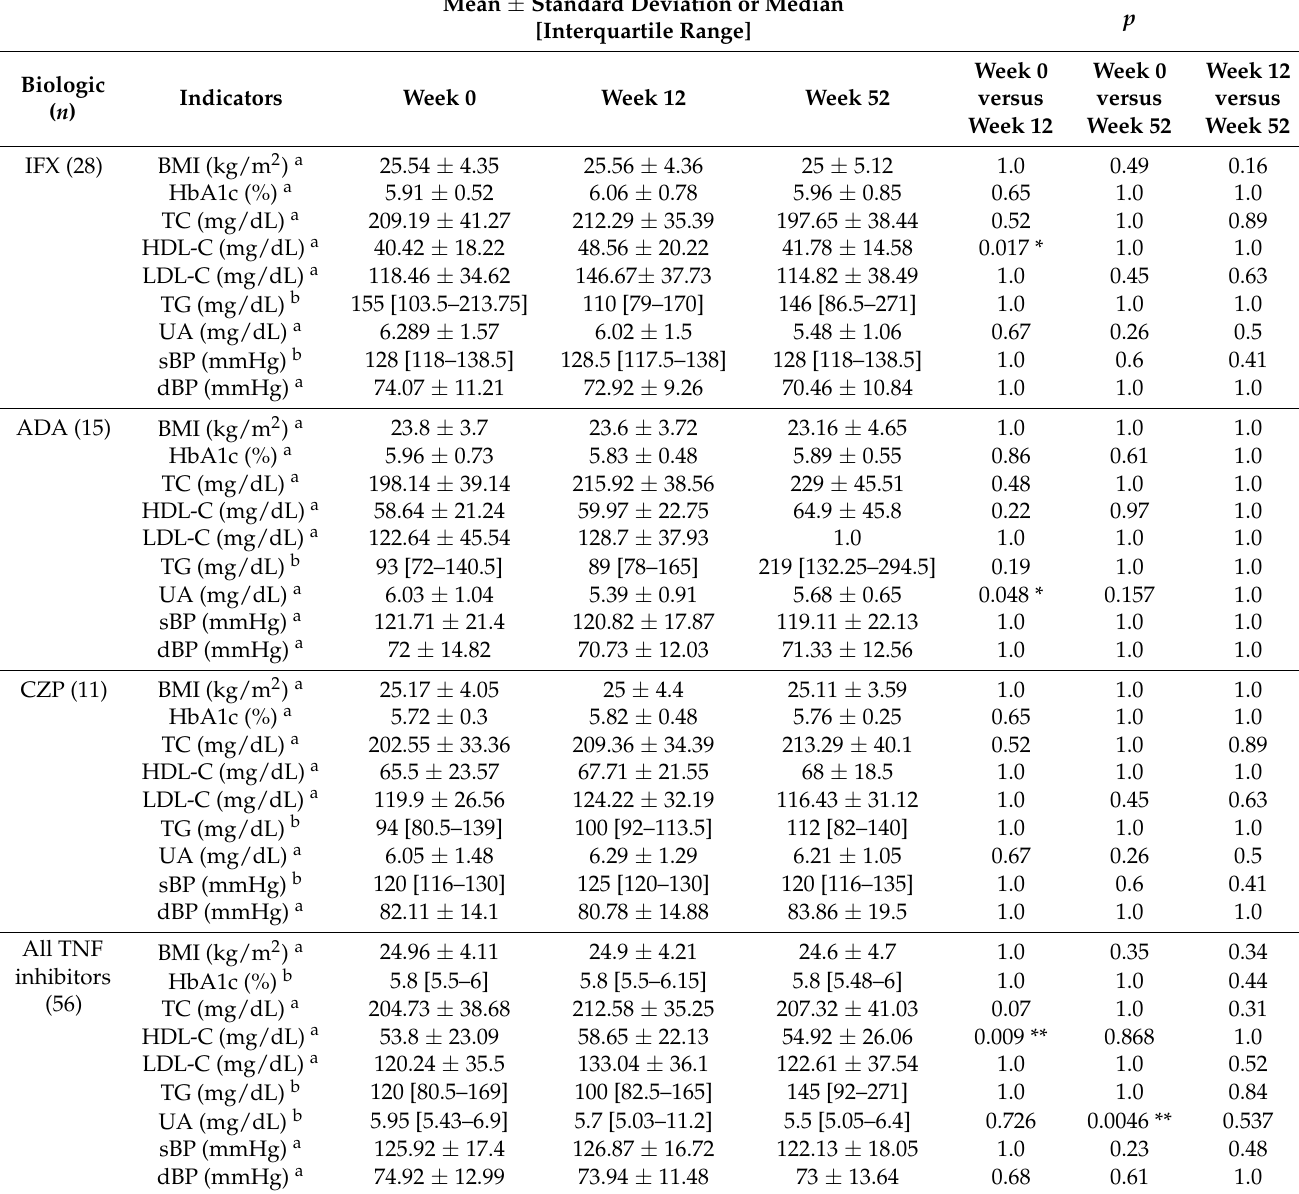
Table 3. The levels of indicators of cardiometabolic diseases at week 0, 12 and 52 of treatment with TNF- α inhibitors. Mean ± Standard Deviation or Median [Interquartile Range]